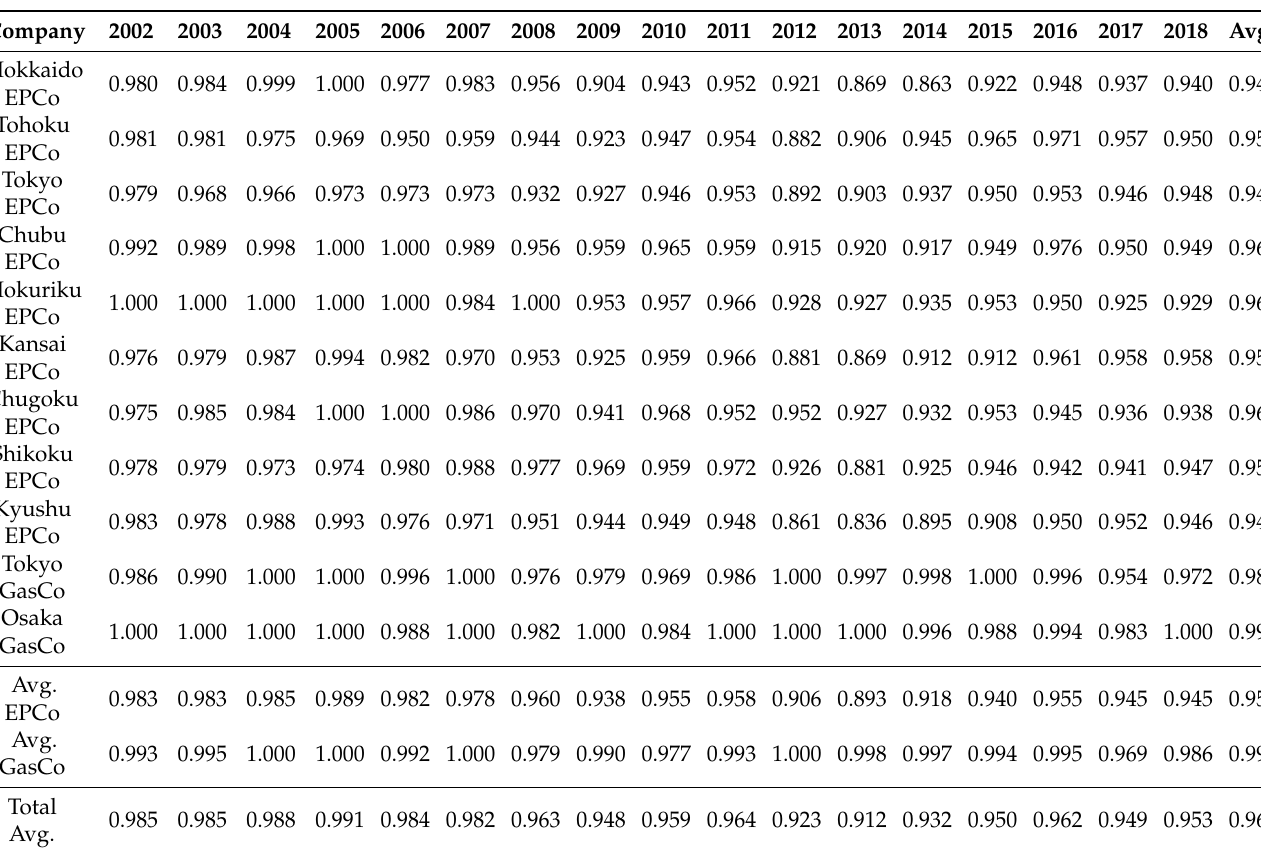
Table 2. Cross-Sectional Operational Efficiencies (CSOE) of Utility Companies: Pooled